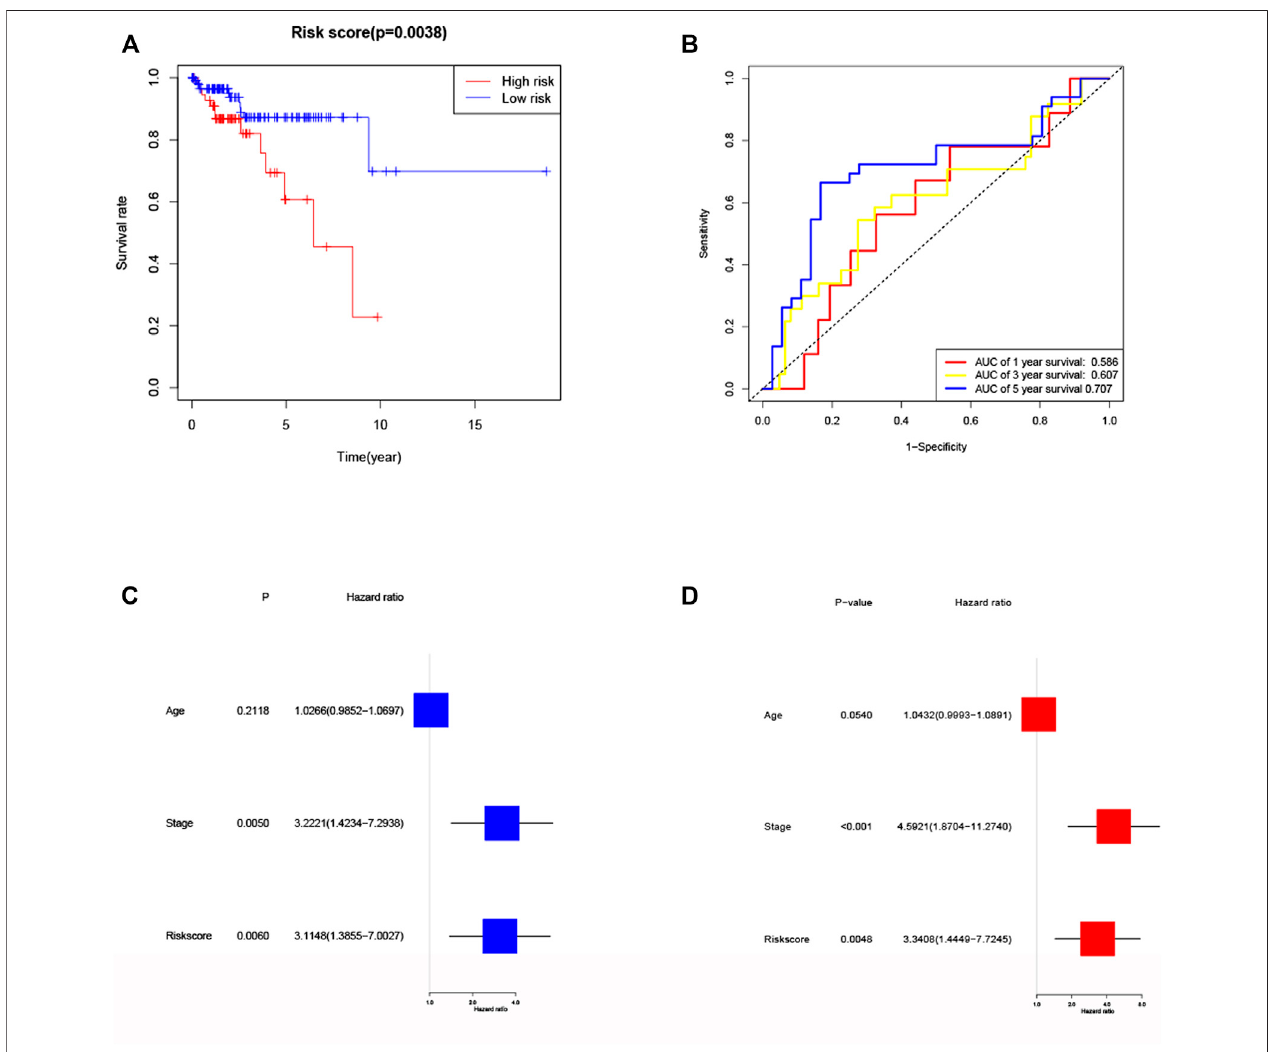
FIGURE6| Validation ofthe riskmodel invalidationcohort. (A) Kaplan – Meier curves for the OSofpatientsinthe high- and low-riskgroups in validation cohort. (B) ROCcurvesdemonstratedthepredictiveef fi ciencyoftheriskscoreat1,3and5 yearsinvalidationcohort. (C) Univariateregressionanalysisoftheriskscoreinvalidation cohort. (D) Multivariate regression analysis of the risk score in validation cohort. (Stage: FIGO stage, I and II vs. III and IV).